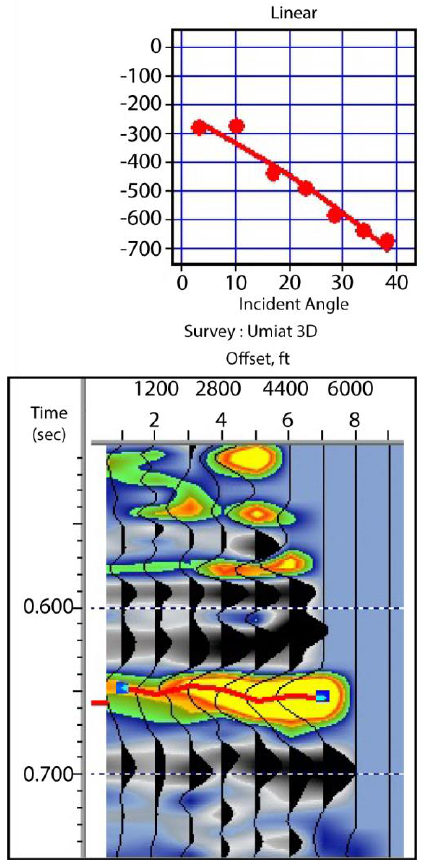
Figure 9. AVO intercept and slope, showing the presence of Class III gas sands within the Lower Grandstand Member at the Umiat Oil Field.